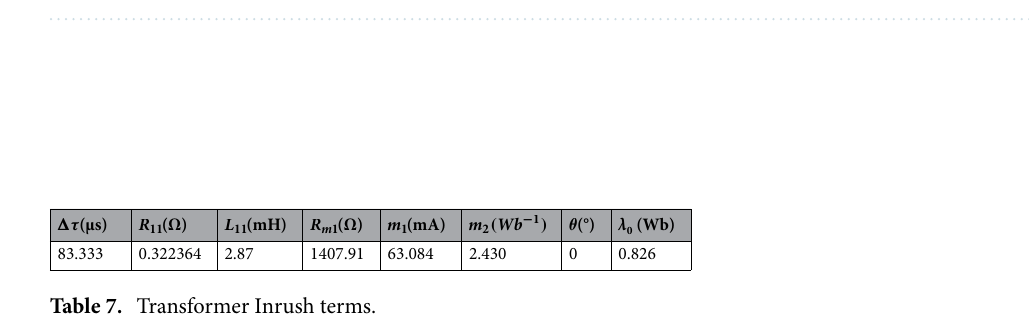
Figure 10. Case 2 transformer performance utilizing the extracted parameters using different optimizers.